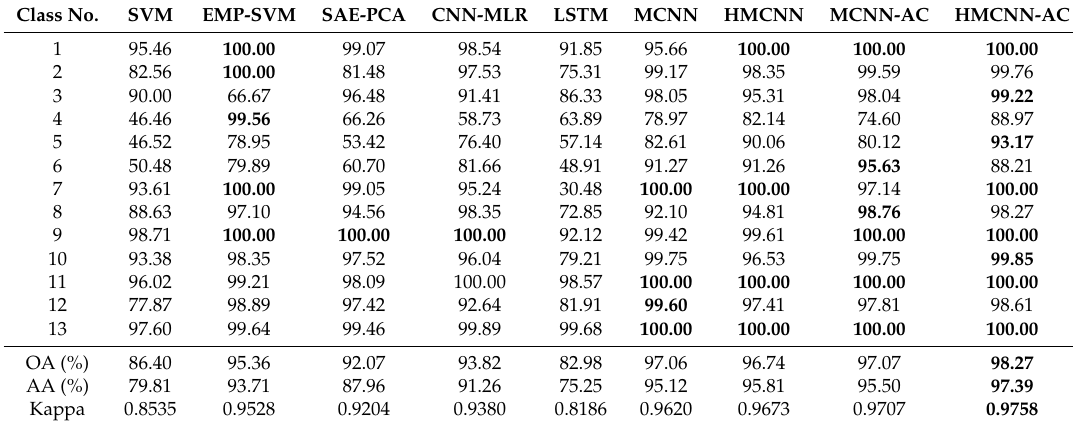
Table 7. Classification accuracy (%) for KSC dataset using 10% training samples via different classification algorithms. The three proposed frameworks HMCNN, MCNN-AC and HMCNN-AC outperform other baseline methods in results.